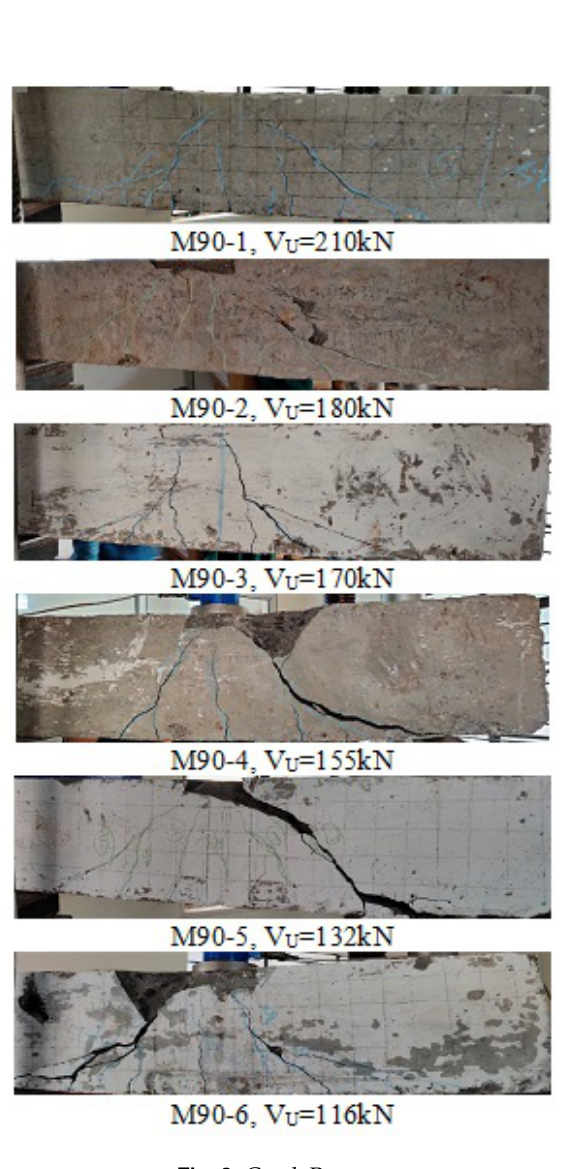
Fig. 3. Crack Patterns